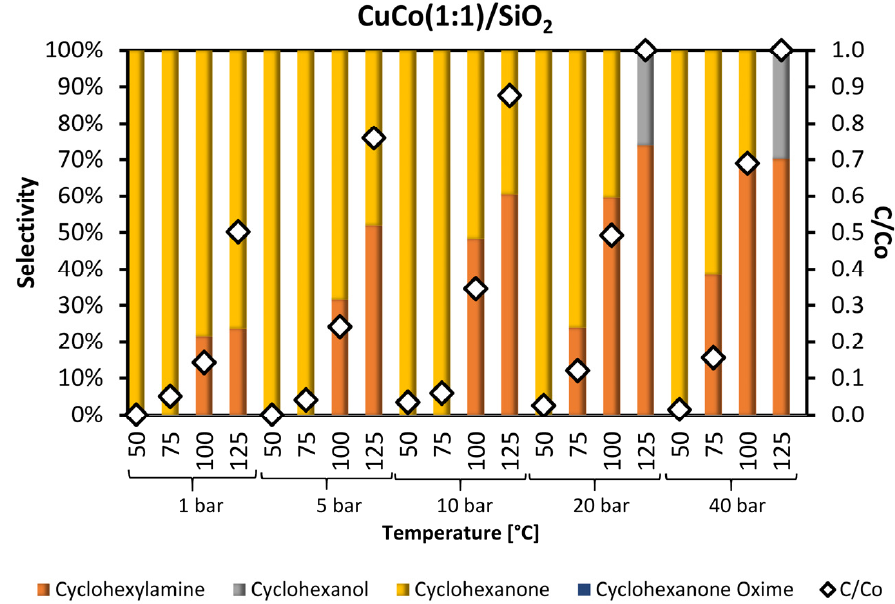
Figure 10. Catalytic hydrogenation of nitrocyclohexane in liquid flow conditions with CuCo(1:1)/SiO 2 .